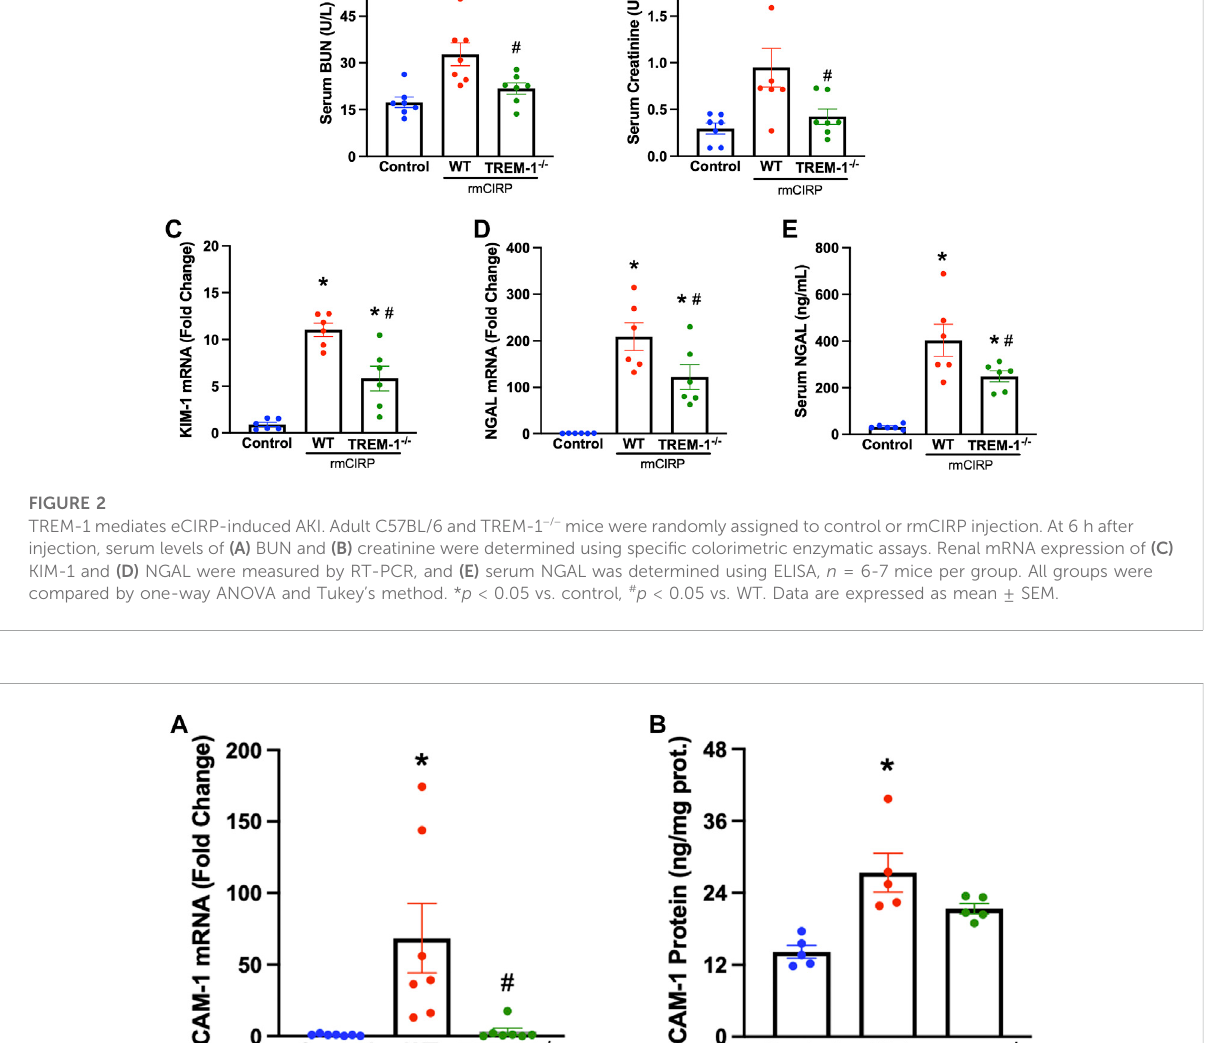
rmCIRP to induce AKI and the renal tissue was evaluated for ICAM-1 expression. The renal tissue of WT mice with CIRP- induced AKI had a 100-fold increase in ICAM-1 mRNA expression and a 2-fold increase in ICAM-1 protein compared to that of control. In TREM-1 − / − mice, however, ICAM-1 mRNA and protein expression were reduced by 98% and 22%, respectively, compared to WT mice (Figures 3A,B).